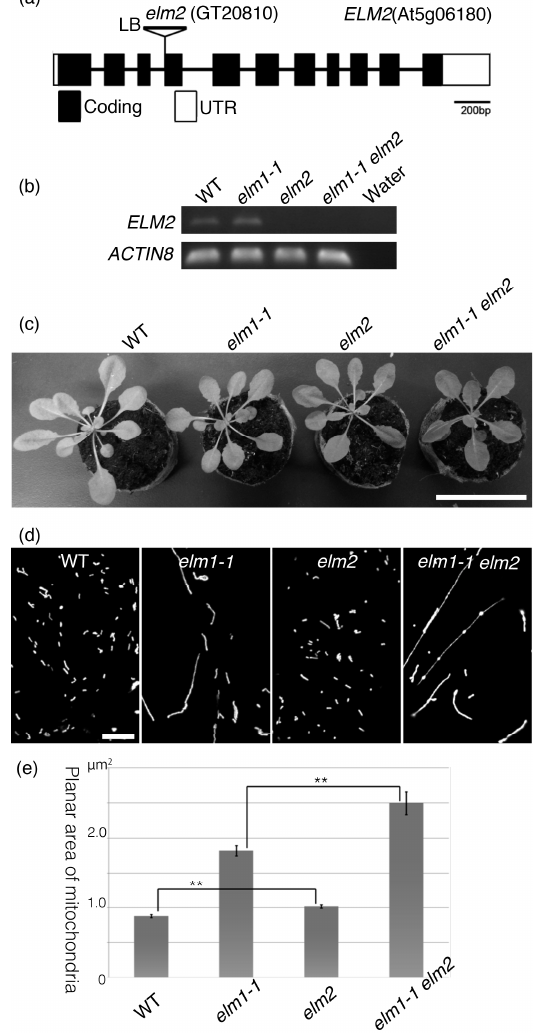
Figure 3. Disruption of ELM2 does not appear to affect mitochondrial morphology much. ( a ) A T-DNA insertion in the end of the 3rd intron in the elm2 mutant. ( b ) RT-PCR of full length of ELM2 ORF (open reading frame) in the wild-type, elm1-1 , elm2 and elm1-1 elm2 double mutants. ( c ) Comparison of growing phenotypes of wild-type, elm1-1 , elm2 and elm1-1 elm2 double mutants. 30-day-old plants. Scale bar, 5 cm. ( d ) Mitochondrial morphologies in the wild-type, elm1-1 , elm2 and elm1-1 elm2 double mutants. Leaf epidermal cells in 14-day-old plants were observed by confocal laser scanning microscopy. Scale bar, 10 μ m, is applicable to the four images. ( e ) Average planar areas of mitochondria of wild type and mutants. ( n > 218 in each of three replications) in each mutant. Error bars show S.E. ** indicates statistical significance at p < 0.01.